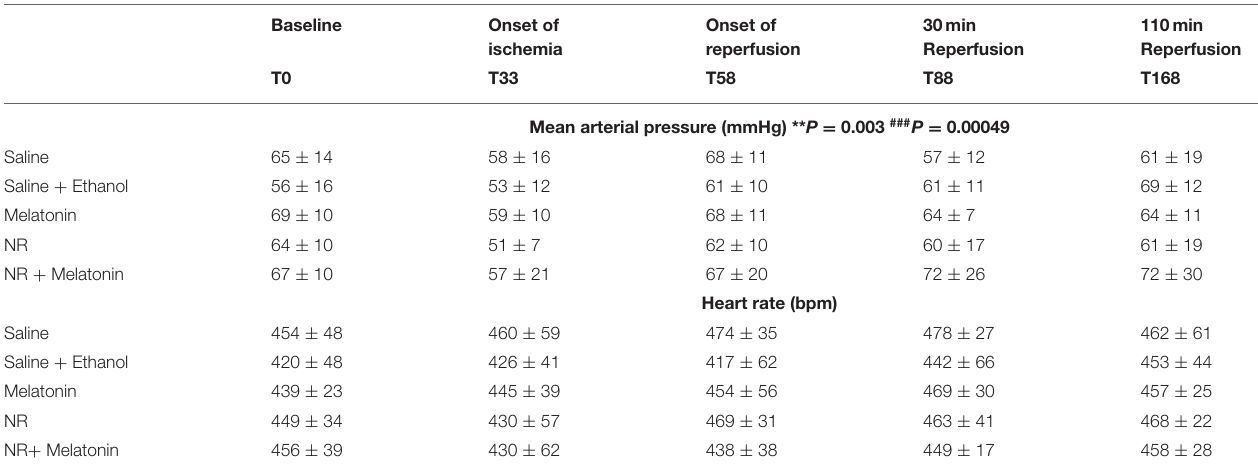
TABLE 2 | Hemodynamic variables throughout the ischemia reperfusion protocol.